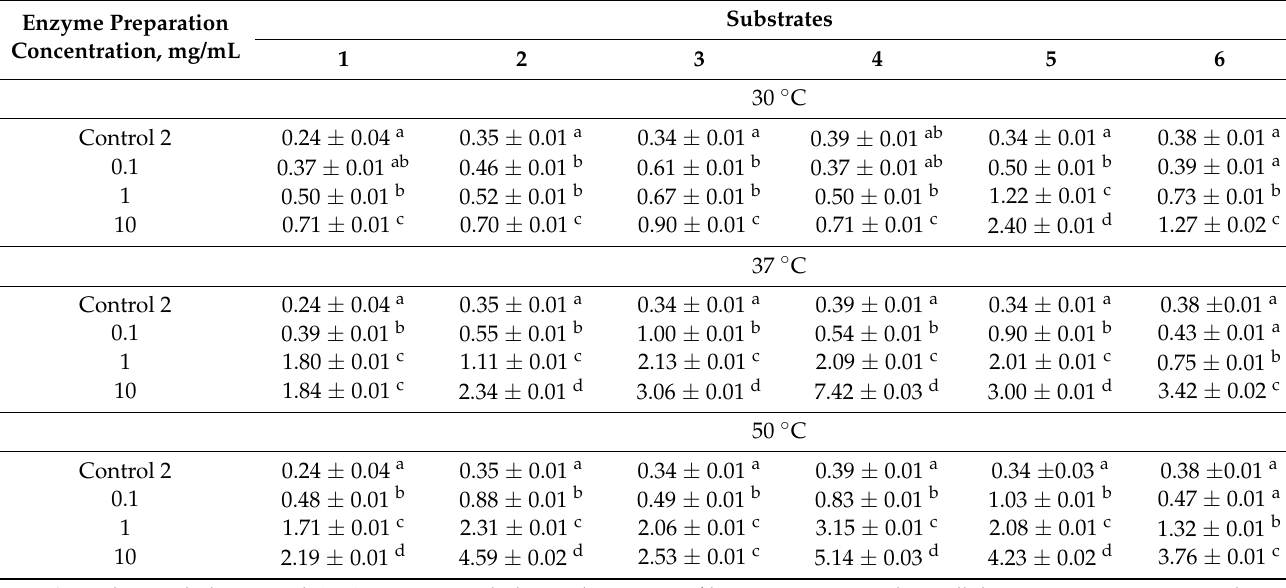
Table 3. Characterization of the cellulase activity (concentration of the reducing substance, mg/mL) of the enzyme preparation.